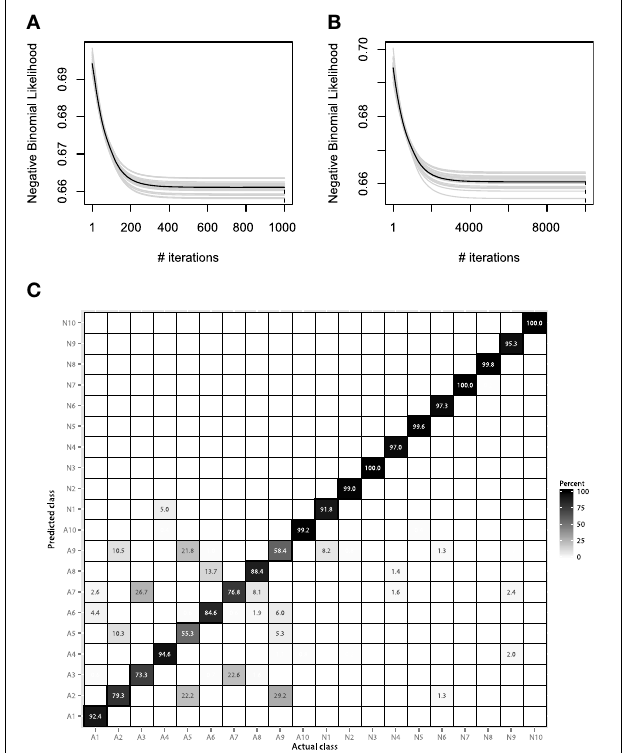
FIGURE 12 | (A) Bootstrap estimates of M for the EMG classification data, held-out error with λ = 0 . 01. (B) Bootstrap estimates of M for the EMG classification data, held-out error with λ = 0 . 001. (C) Confusion matrix for the EMG activity classification test